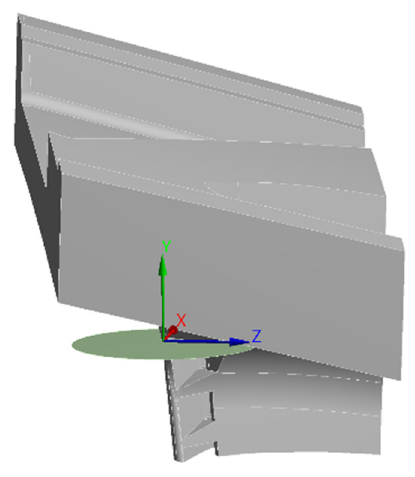
Figure 11. Coordinate system at the crack apex.